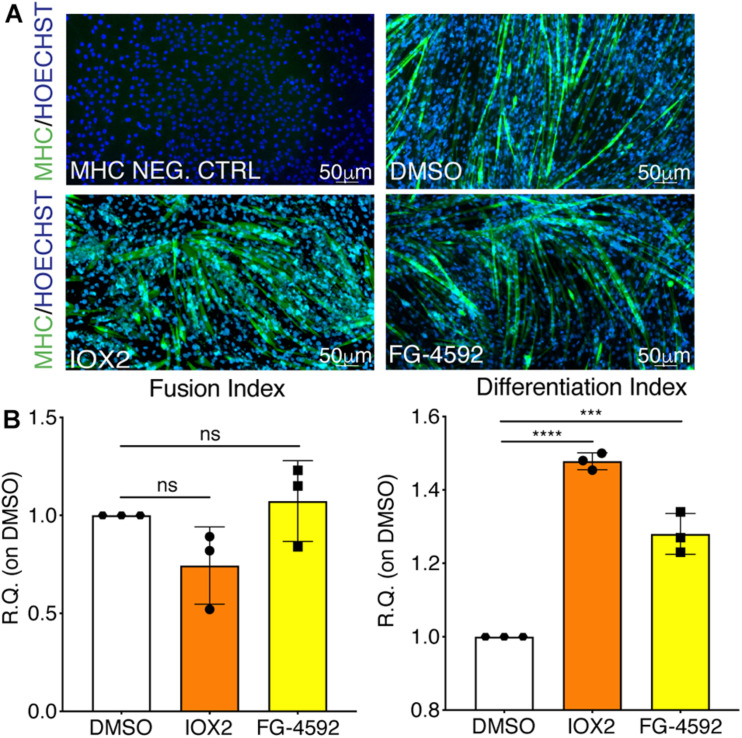
Effects of hypoxia inducible factor-1α (HIF-1α) pharmacological activation on skeletal muscle differentiation. (A) Immunofluorescence staining of myosin heavy chain (MHC; green) in proliferating (MHC NEG. CTRL) and differentiated murine myoblasts treated with IOX2 or FG-4592 for 24 h in growth medium (GM) and then switched to differentiation medium (DM) without the prolyl-hydroxylases (PHDs) inhibitors for 7 days. Nuclei were stained with Hoechst 33342. Magnification is 200×. (B) Quantification of the fusion index, as the ratio between MHC-positive nuclei and the total number of nuclei, and of the differentiation index, as the ratio between myotubes area and MHC-positive nuclei at the end of differentiation (n = 3). Data information: all data represent mean ± SD. ***p < 0.001, ****p < 0.0001 (Ordinary one-way ANOVA).